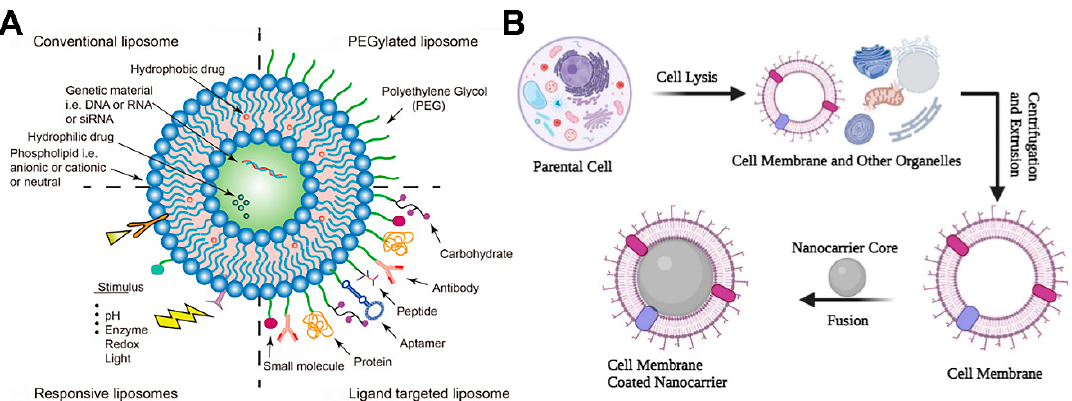
Figure 1. Schematic diagram of functionalized liposomes. ( A ) Strategies of multifunctional liposome delivery for cancer therapy. Reproduced with permission from reference [12]. Copyright 2020, the author(s). ( B ) Cell membrane-coated nanoparticles. Reproduced with permission from [13]. Copyright 2022, the author(s).